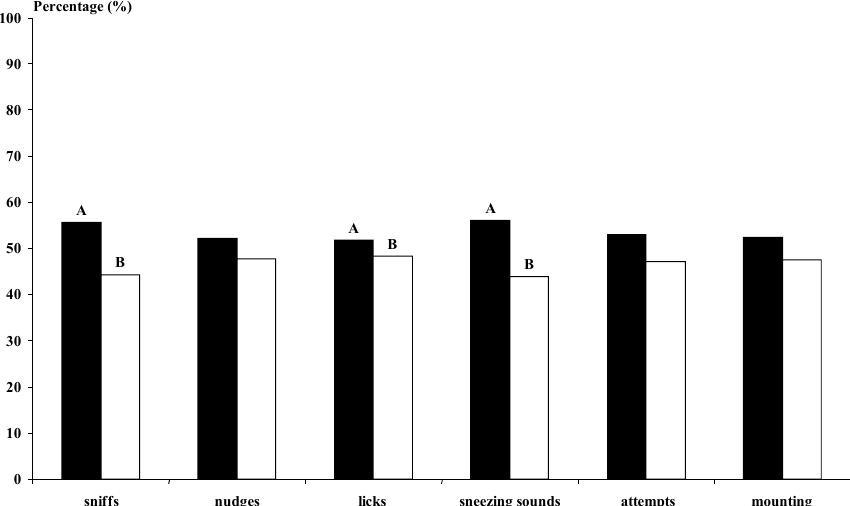
Figure 3. Types of sexual advance (%) performed by the males after females were submitted to the male effect using photoperiod-treated males ( , n = 6) or males exposed to the natural photoperiod ( □ , n = 6). Half of each group was com- posed of Murciano-Granadna bucks, and the other half was composed of Blanca Andaluza bucks.Different letters (A, B) differ significantly ( p < 0.01). Sniffs (when the buck sniffed the anogenital area of the doe). Licks (when the buck licked the flanks of the doe). Nudges (when the buck kicked the doe). Sneezing sounds (sounds emitted by the bucks). Mounting attempts (when the buck attempted to mount the doe without intromission). Mounting with intromission (when the bucks mounted the doe with intromission).